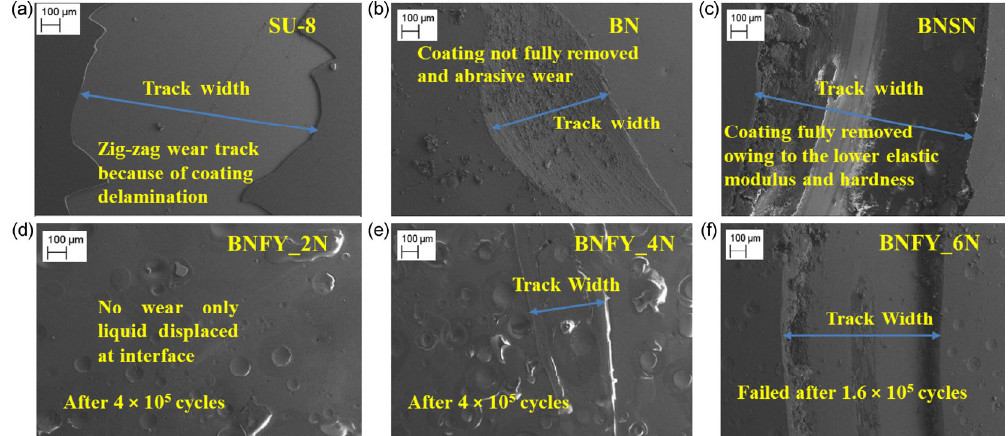
Fig. 10 Optical microscope images of the samples after the tribology test: (a) SU-8 at 2 N, (b) BN at 2 N, (c) BNSN at 2 N, (d) BNFY at 2 N, (e) BNFY at 4 N, and (f) BNFY at 6 N. All tests were carried out at a constant sliding speed (0.28